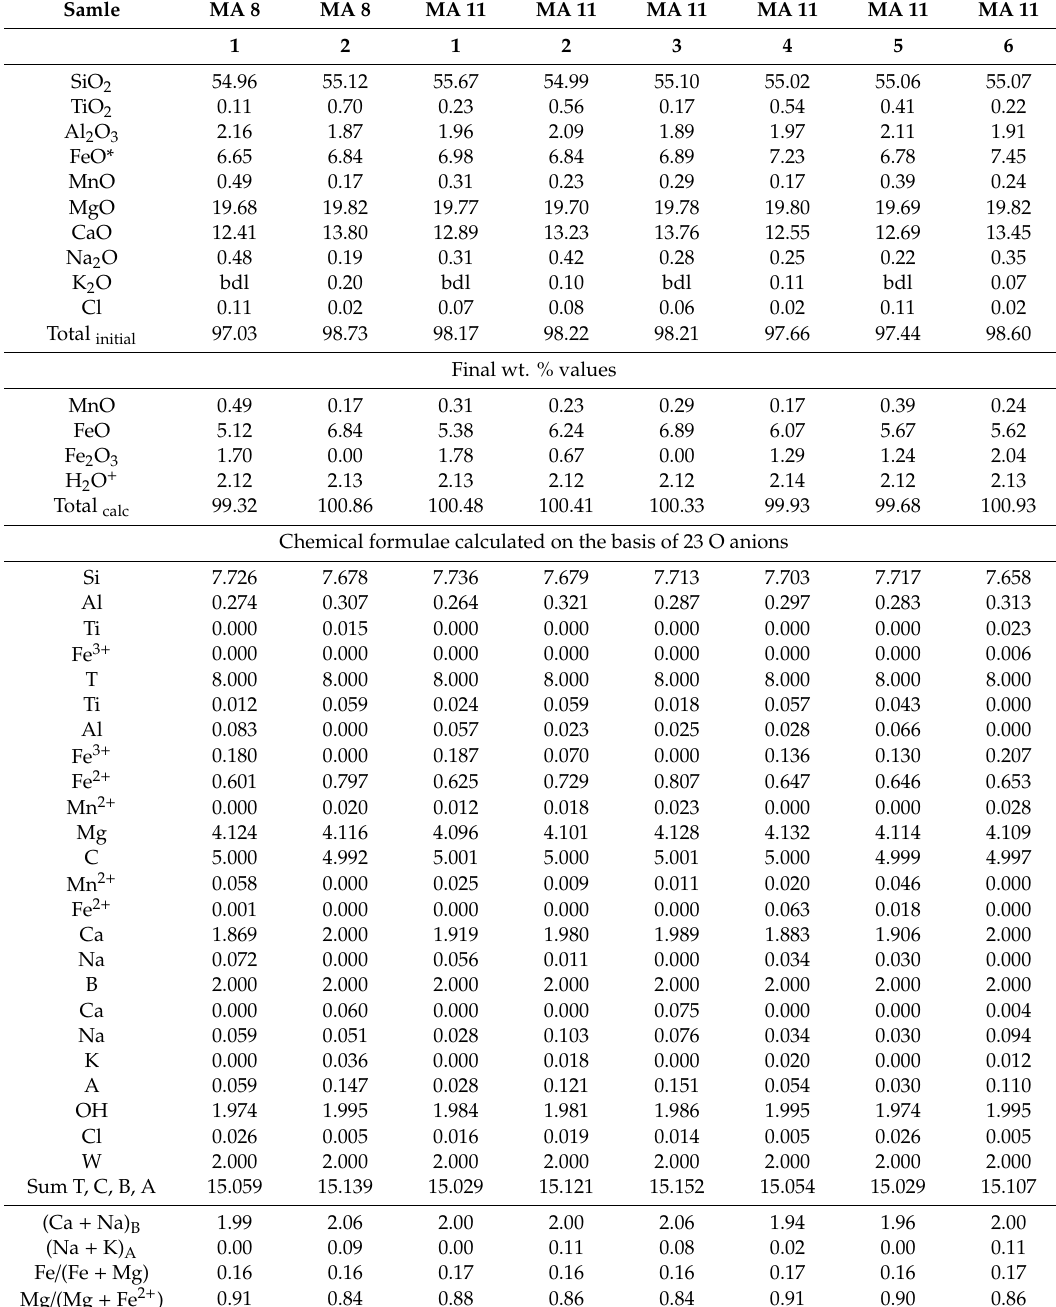
Table 5. Representative microanalyses (wt. %) and calculated formulae of hydrothermal actinolite in sodic-calcic alteration in the Maronia deposit. FeO*: total iron as FeO; bdl: below detection limit.